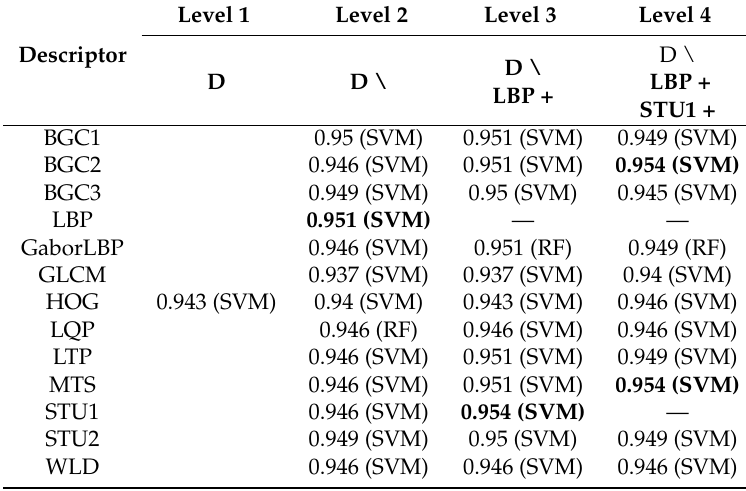
Table 5. Backward Subset Selection of descriptors applied to 4 × 4 gridded image (also known as BSS 4 ×